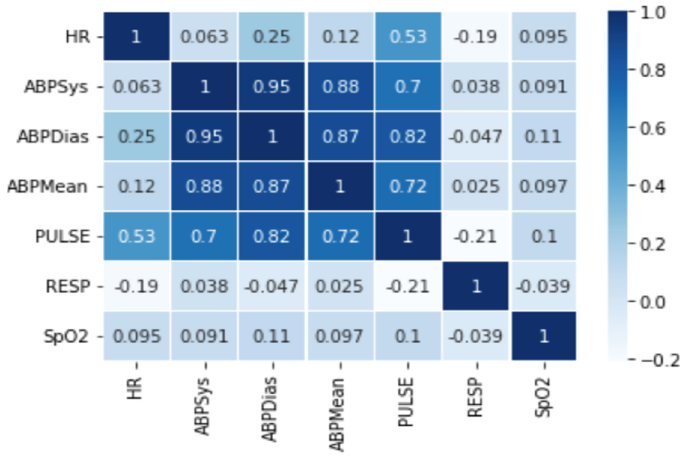
Figure 10. Correlations between physiological data. Table 6. Performance evaluation (different datasets with correlated ABPDias with HR sensors).